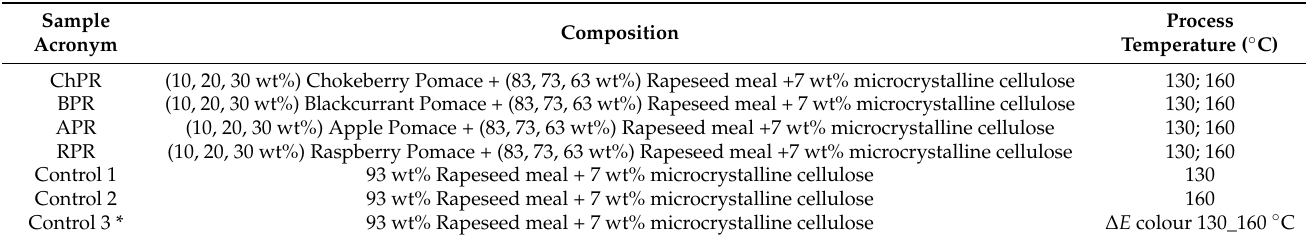
Table 1. Raw material composition and temperature parameters of the biocomposites production process. Sample